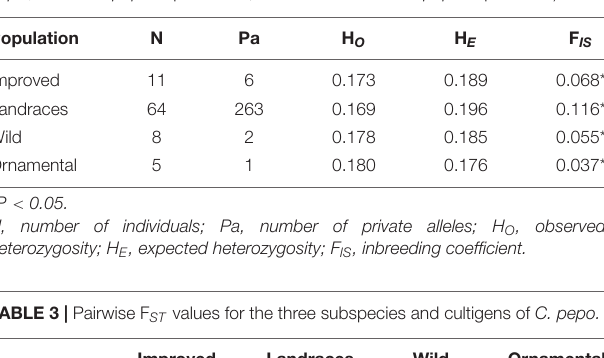
pepo , Wild = C. pepo ssp. fraterna, and Ornamental = C. pepo ssp. ovifera ).